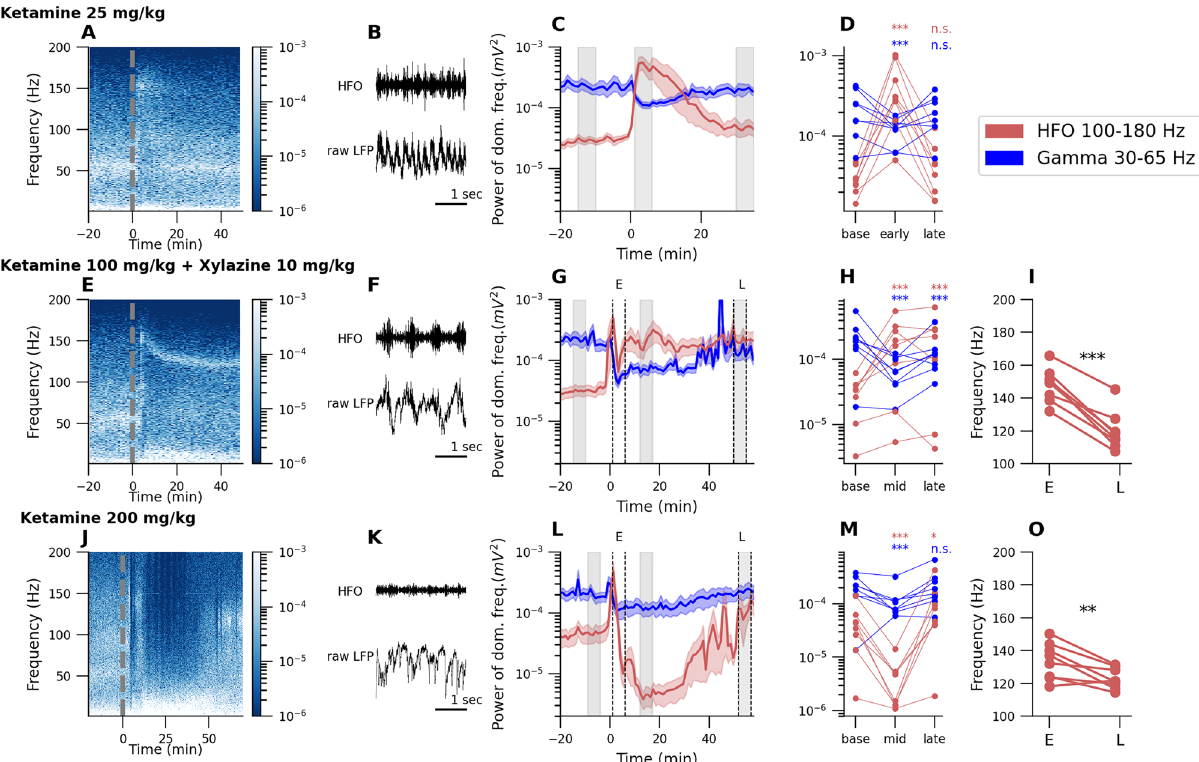
Figure 1. Effect of ketamine (subanesthetic and anesthetic doses) and KX anesthesia on 30–65 Hz and 100–180 Hz oscillations in the rat OB. First row ( A – D ) presents results for subanesthetic ketamine 25 mg/kg, second row ( E – I ) for ketamine 100 mg/kg + xylazine 10 mg/kg (KX) anesthesia and third row for anesthetic dose of ketamine 200 mg/kg. First column ( A , E , J ): Example spectrograms computed from the OB before and after injection. Dotted line at t = 0 is injection time. Second column ( B , F , K ): Example raw waveform (bottom) and filtered signal in HFO band 100–180 Hz (top). Third column ( C , G , L ): Extracted data from spectrograms of the power of dominant frequency for 30–65 Hz and 100–180 Hz activity (mean across rats n = 8). The column ( D , H , M ): Individual traces of HFO and gamma power taken from three time points (marked with grey bars in C , G , L plots). Both subanesthetic ketamine and KX administration reduced gamma power and substantially increased HFO power (*p<0.05, **p<0.01, ***p<0.001, and n.s. (not significant) with respect to baseline). ( I , O ): Comparison of dominant frequency for the 100–180 Hz band just after injection of ketamine 25 mg/kg or KX for early E and late L time points (**p<0.01,